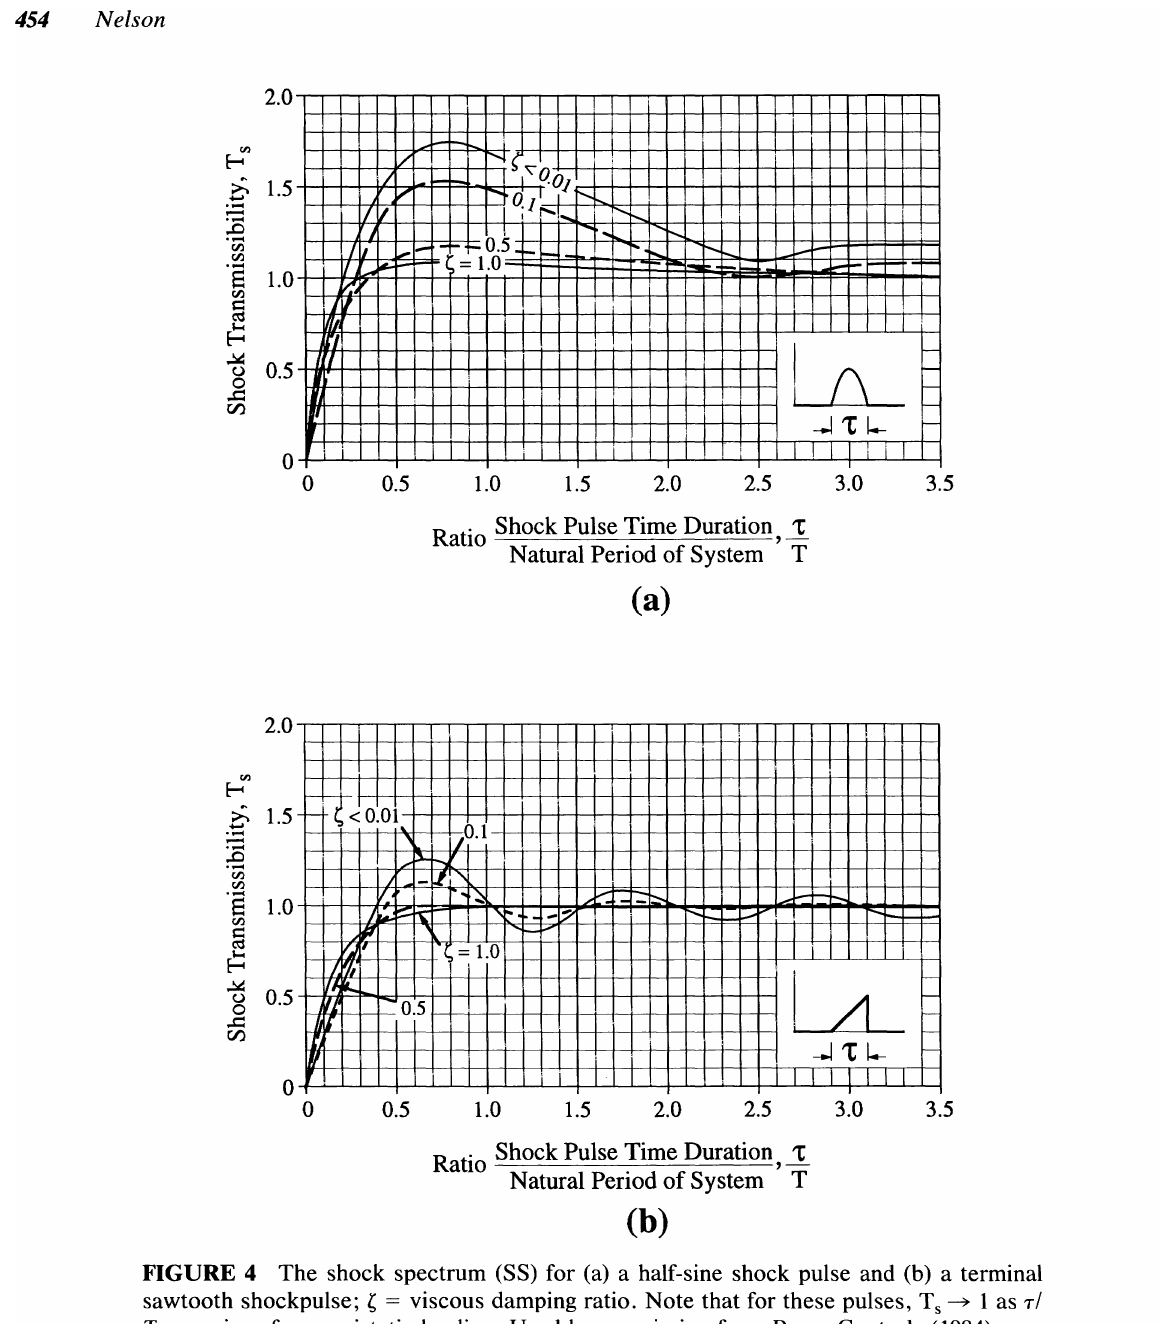
FIGURE 4 The shock spectrum (SS) for (a) a half-sine shock pulse and (b) a terminal sawtooth shockpulse; ~ = viscous damping ratio. Note that for these pulses, Ts ~ I as Ti T ~ :>:0, i.e., for quasi static loading. Used by permission from Barry Controls